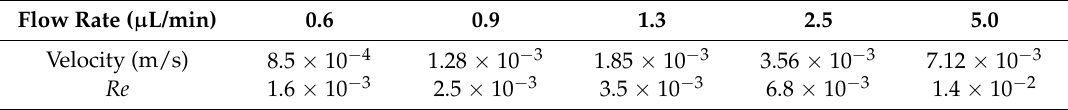
Table 3. Various flow rate in this work and relevant Re and outlet